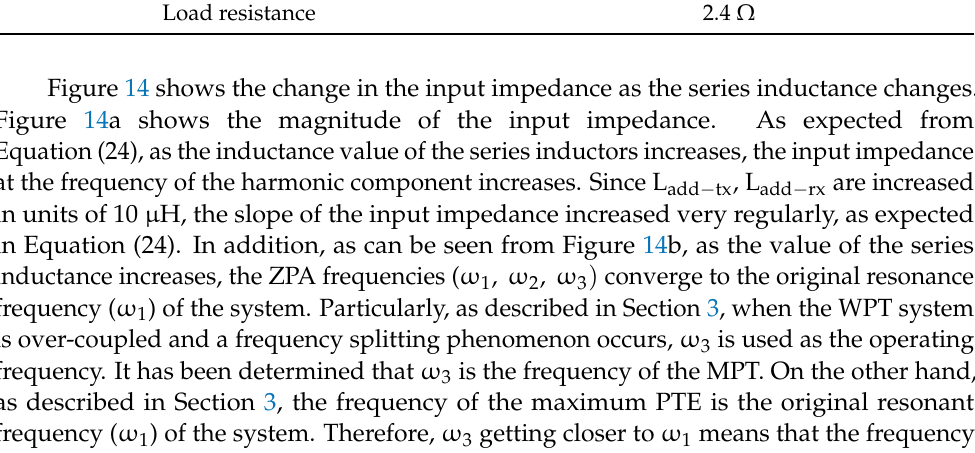
Table 7. Inductance of series inductors (L add ) and corresponding compensation capacitance values (C Tx , C Rx ). Inductance of Coils (L Tx , L Rx ) [ μ H]